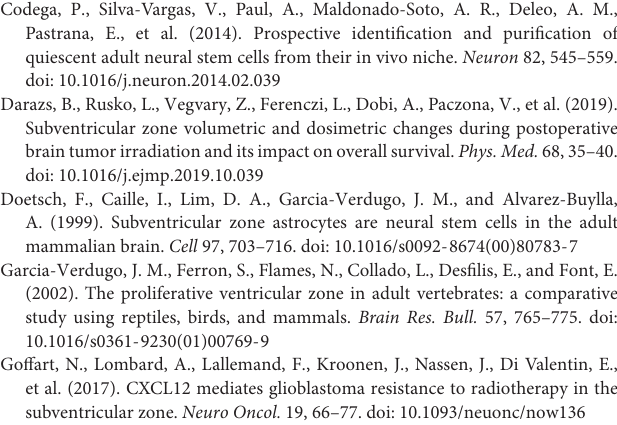
Supplementary Figure 1 | Representative MRI of the patients with ependymal or ventricle entry. (A) MRI image of ependymal-treated patients. The distance between the contrast-enhancing lesion and the lining of the ventricle was more than 2 mm. (B) Representative pictures of GBM invasion into the